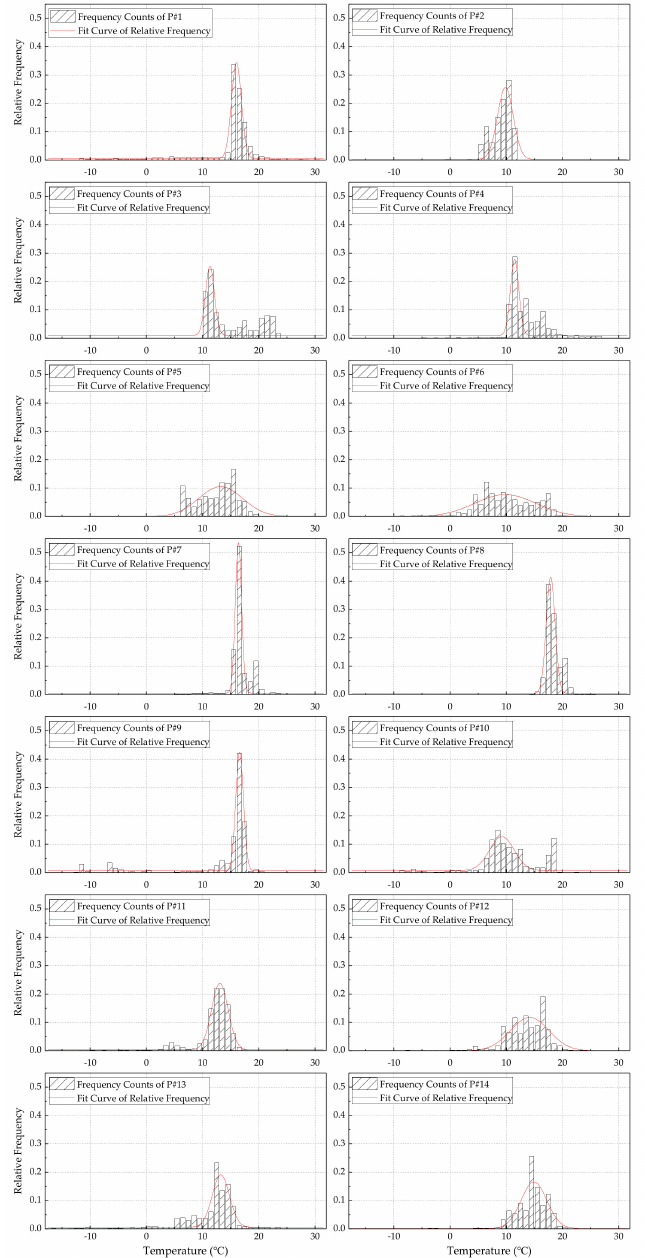
Figure A2. Personal experienced temperature distributions from the 14 volunteers. P#1–14 is the volunteers’ ID number and matches the ID in Table